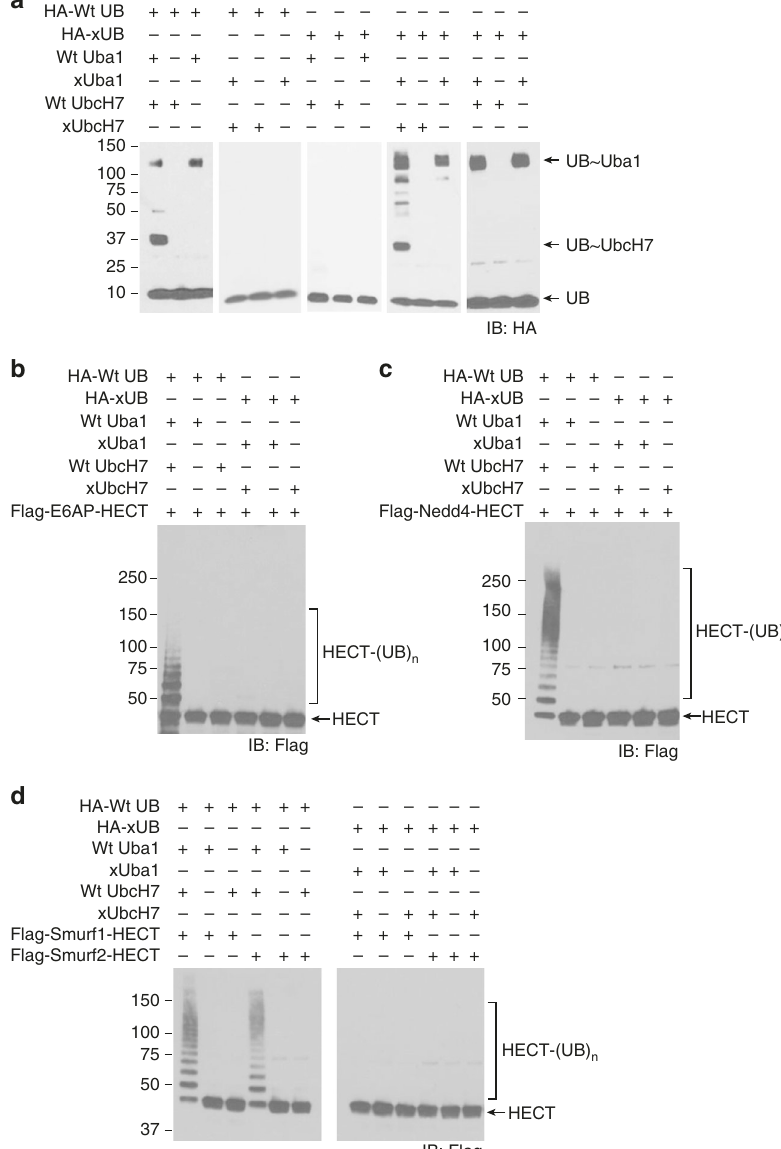
Fig. 1 Orthogonality of the xUba1 – xUbcH7 pair with the wt UB transferring enzymes. a Wt UB can be transferred to wt UbcH7 by wt human Uba1, but it cannot be activated by human xUba1 for transferring to xUbcH7. Vice versa, xUB can be activated by xUba1 for transferring to xUbcH7, but it cannot be activated by wt Uba1 for transferring to wt UbcH7, nor can it be transferred to wt UbcH7 by xUba1. The protein gels were run under